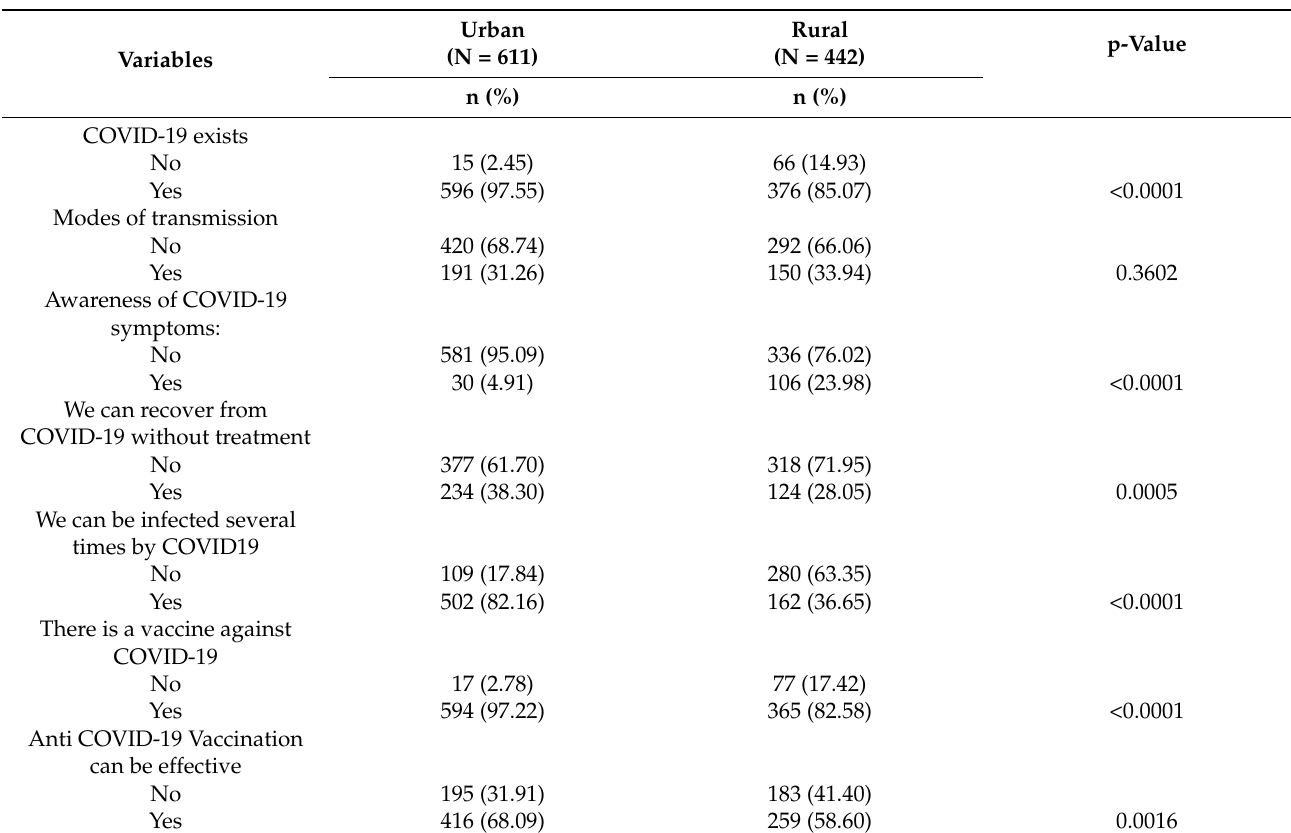
Table 2. Distribution of respondents according to their knowledge on the existence and transmission routes of